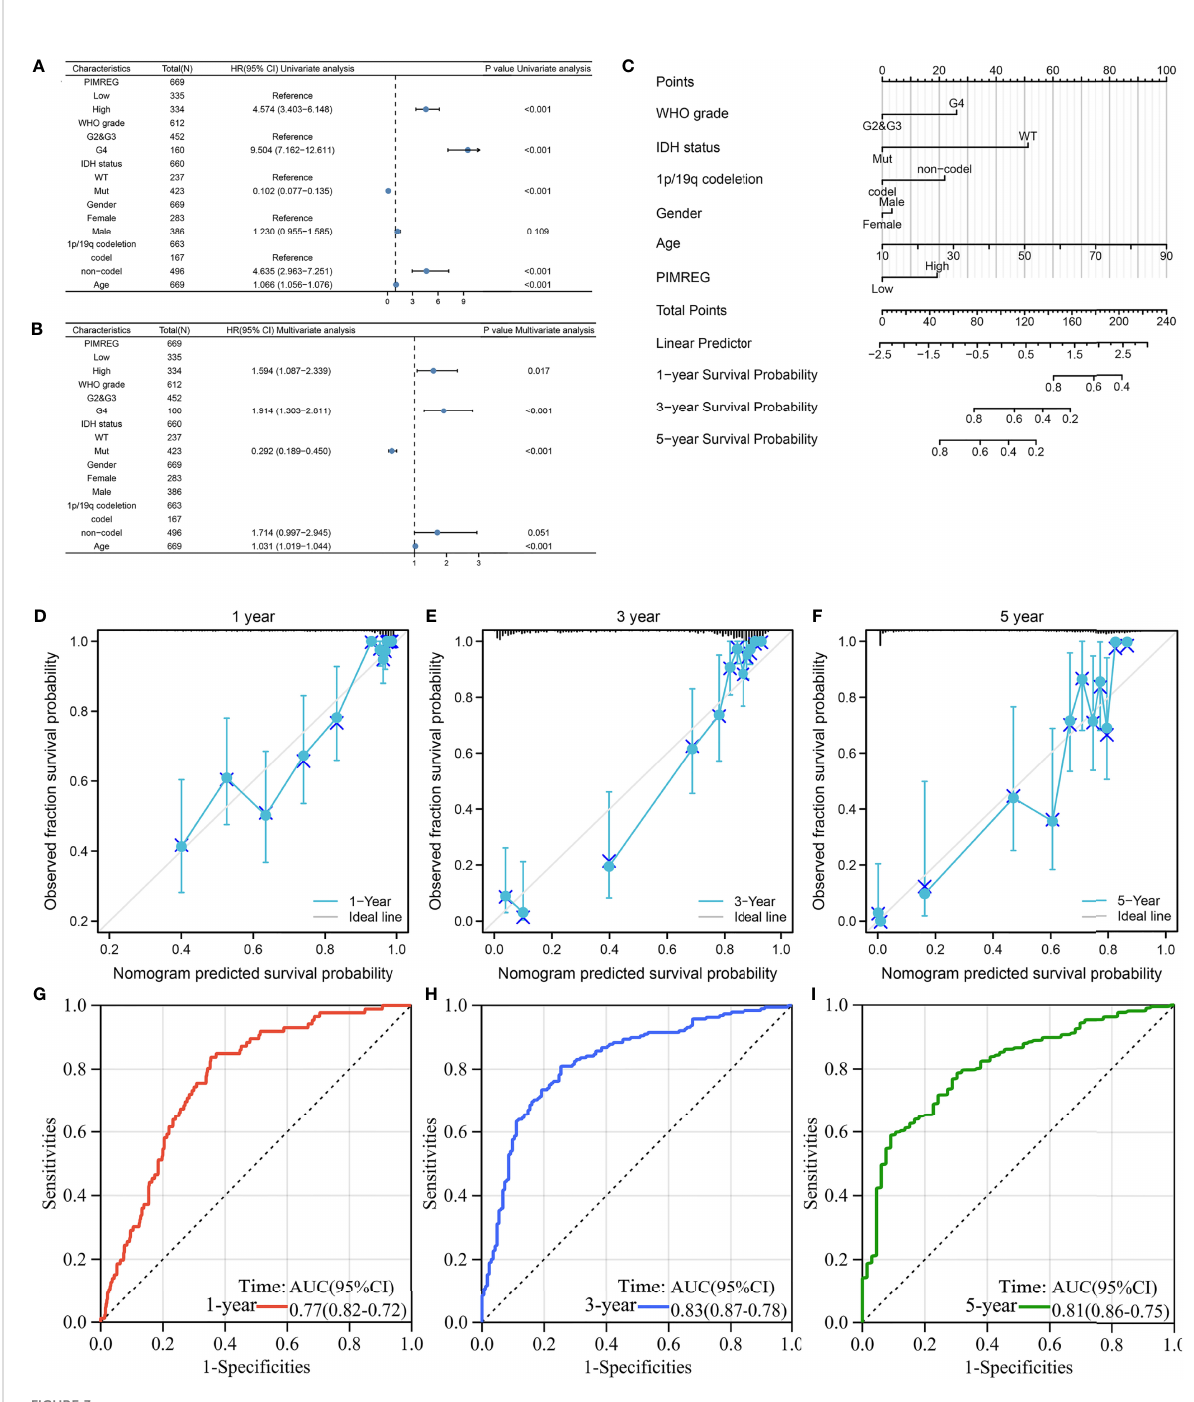
FIGURE 3 The prognostic value of PIMREG in glioma. (A, B) Univariate and multivariate Cox regression visualized in the forest plot. (C) Nomogram and calibration plots (D – F) predicting the 1-year, 3-year and 5-year OS of glioma patients. (G – I) Predictive ability for 1-, 3-, and 5-year prognosis with PIMREG expression by time-dependent ROC curve